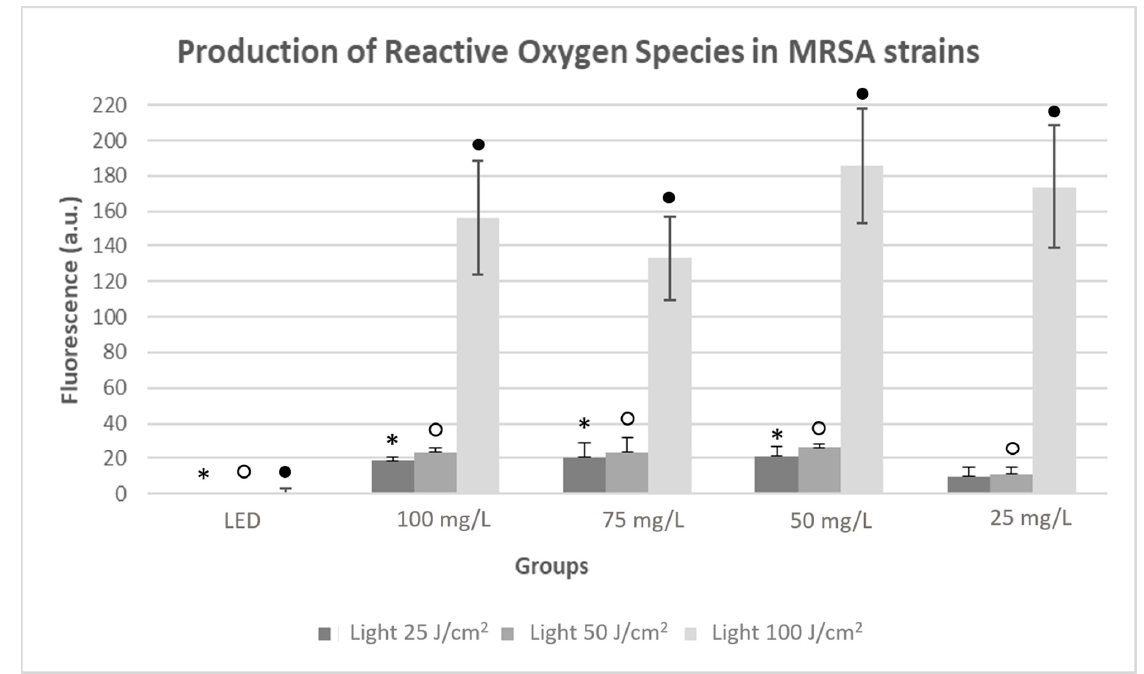
Figure 9. Production of ROS by MRSA strains, with a Light control group without PS (LED); Photodithazine ® at 25, 50, 75, and 100 mg/L; all irradiated (Light) at the fluences of 25, 50, and 100 J/cm 2 . * Significant differences were observed between the LED group to 100, 75, and 50 mg/L with light 25 J/cm 2 groups. ○ Significant differences were observed between the LED group to 100, 75, 50, and 25 mg/L with light 50 J/cm 2 groups . ● Significant differences were observed between the LED group to 100, 75, 50, and 25 mg/L with light 100 J/cm 2 groups.